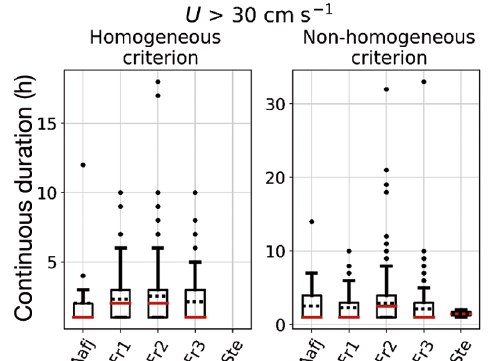
Fig. 7. Number of consecutive hours with current speeds exceeding 30 cm s −1 based on both the homogeneous and non-homogeneous water column criterion. Other details are the same as for Fig.